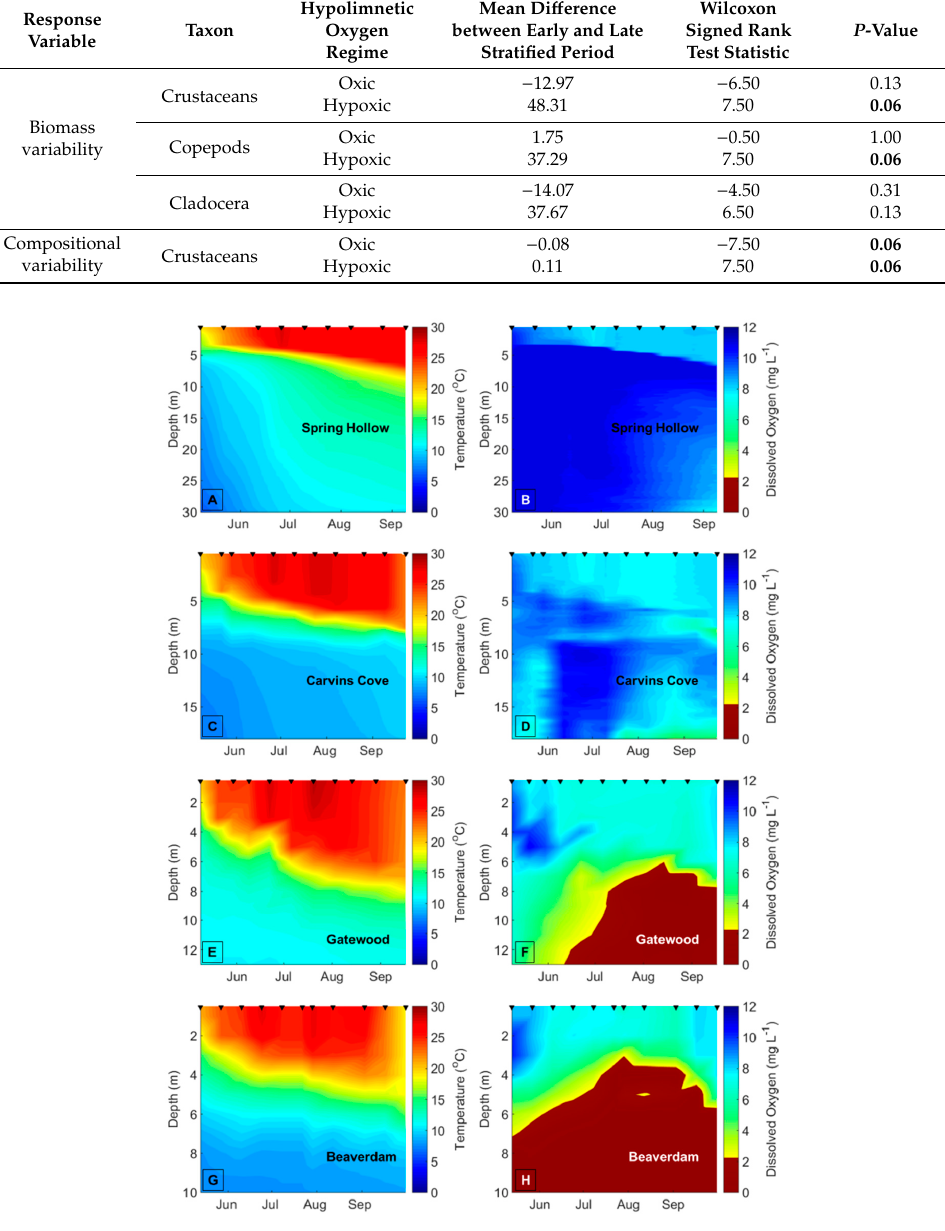
Figure A1. Temperature and dissolved oxygen depth profiles of the four focal reservoirs during the summer stratified period in 2015. The color scale for the dissolved oxygen concentrations highlights the hypoxia threshold at 2 mg L − 1 . The hypolimnia of Spring Hollow ( A , B ) and Carvins Cove ( C , D ) remained oxic; however, the hypolimnia of Gatewood ( E , F ) and Beaverdam ( G , H ) developed hypoxia. Black triangles on the top of each panel represent days sampled, and the intervening data were interpolated.